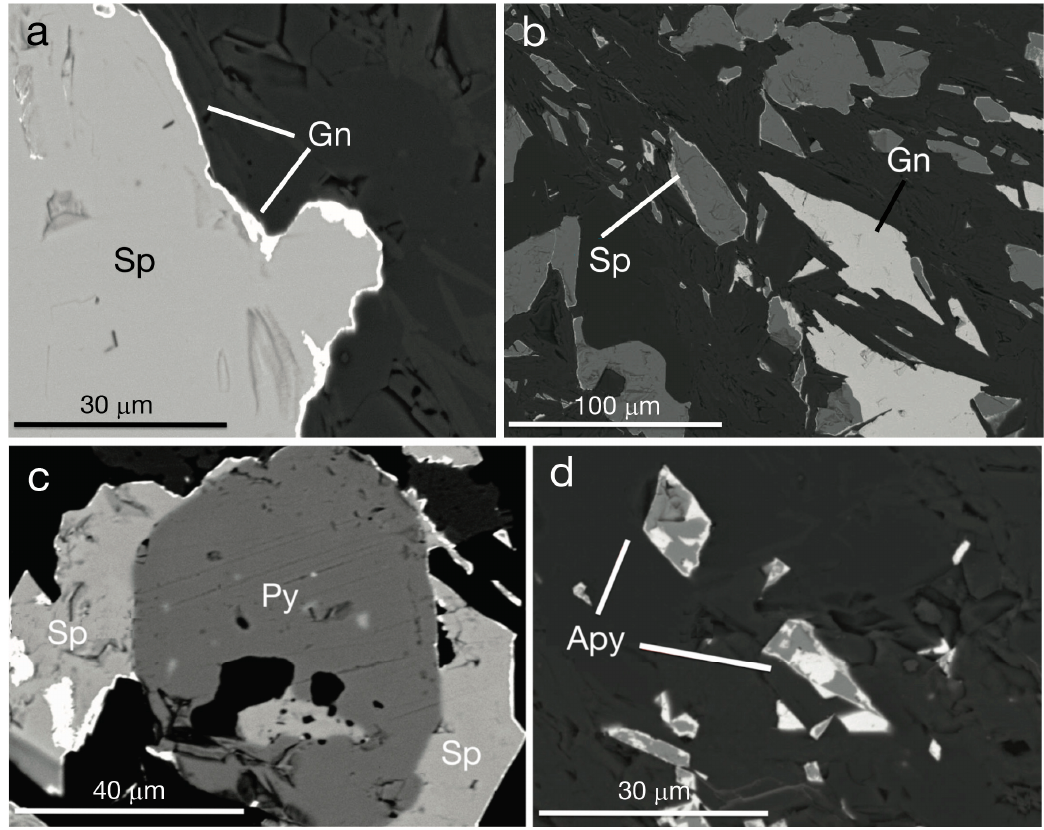
Figure 8. Backscatter electron SEM micrographs of sample KDD 125-8. Mineral chemistry was determined through EDS. ( a ) Sphalerite with galena border associated with quartz grains; ( b ) Sphalerite and galena elongated within the quartzwacke; ( c ) Pyrite grain associated with sphalerite; ( d ) Arsenopyrite intergrown with As-rich sphalerite. Apy = arsenopyrite; Gn = galena; Py = pyrite; Sp = sphalerite.